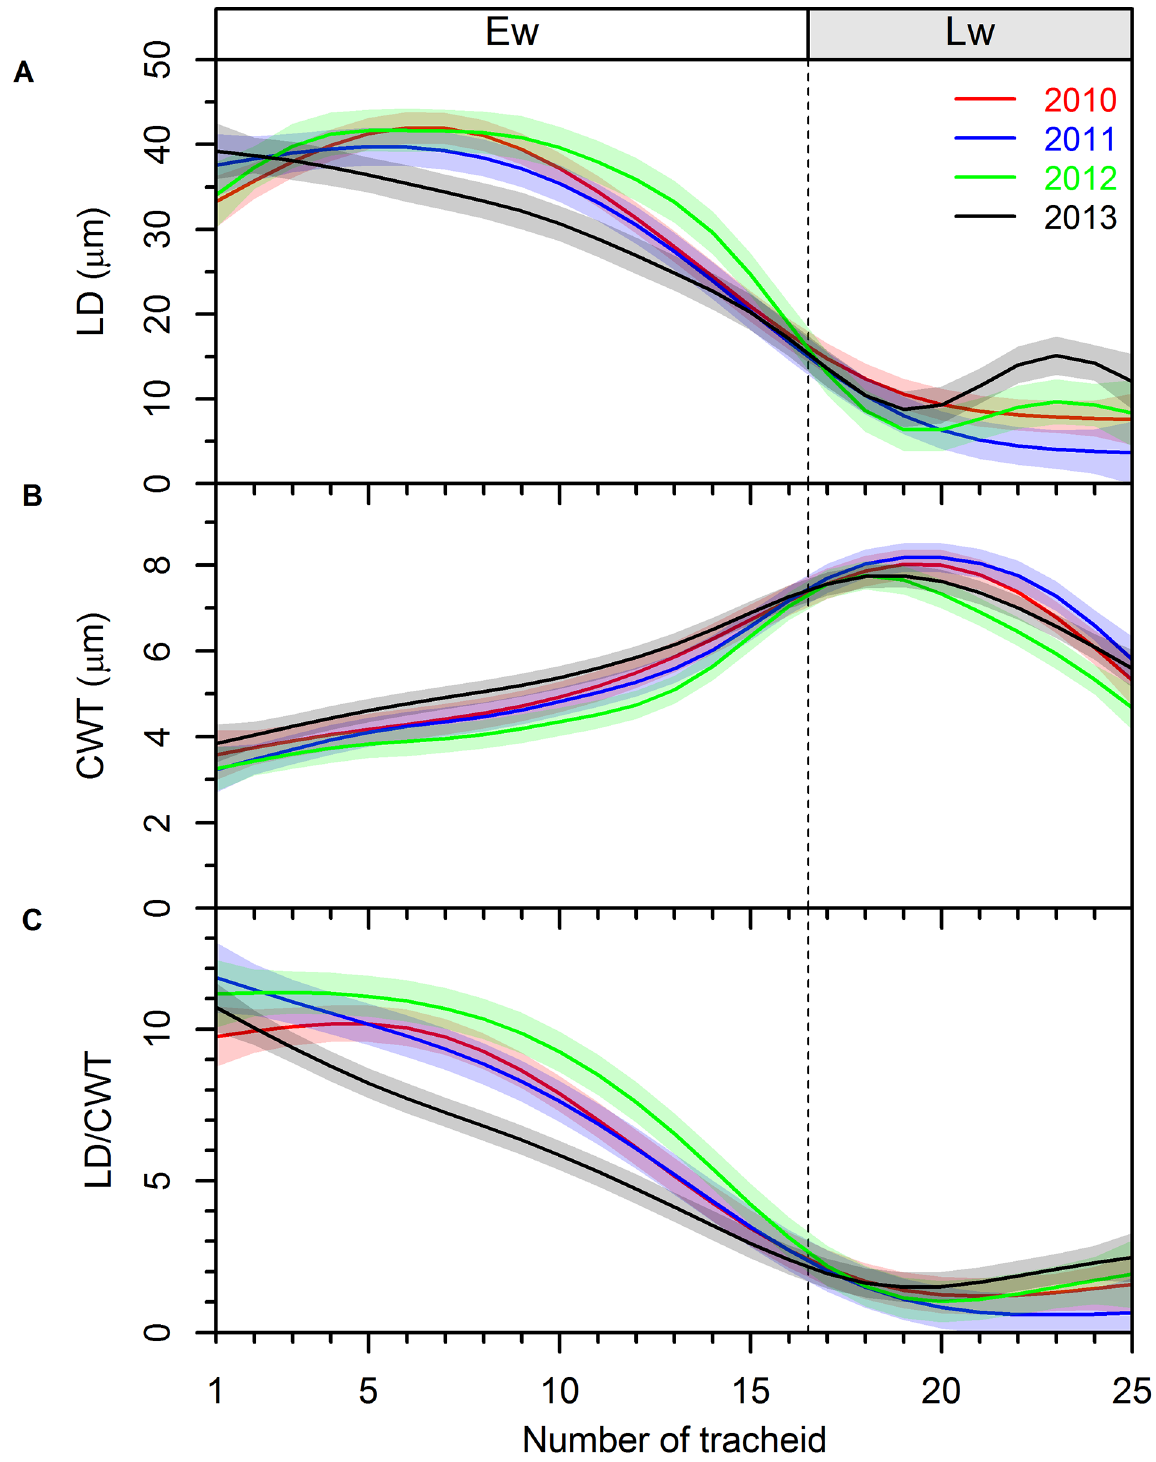
Fig 4. Standardized tracheidograms for the four years (2010 – 2013). The number of tracheids per ring was set to 25 and each standardize tracheidogram contains 16 tracheids in earlywood (Ew) and 9 in latewood (Lw). A) Lumen diameter (LD); B) Cell wall thickness (CWT); C) Ratio of LD to CWT (LD/CWT). The color lines represent the means and the shaded areas the 95% confidence